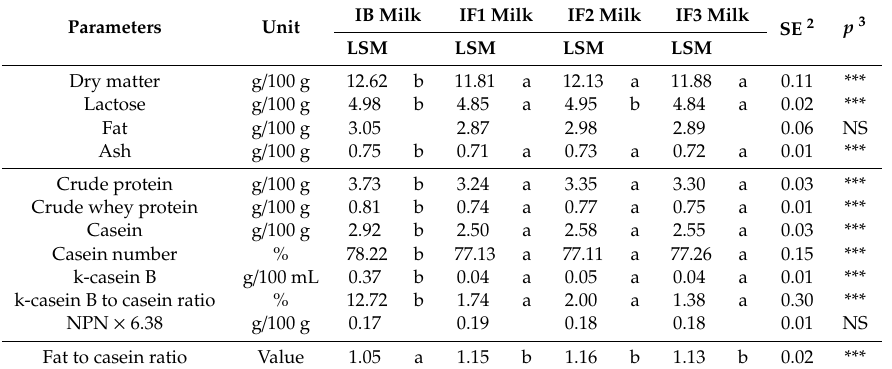
1 In each trial, four cheese-making trials were performed in parallel: three with milk collected from three Italian Friesian cattle herds (IF1, IF2 and IF3) (each cheese-making was made with the milk of a single herd) and one with